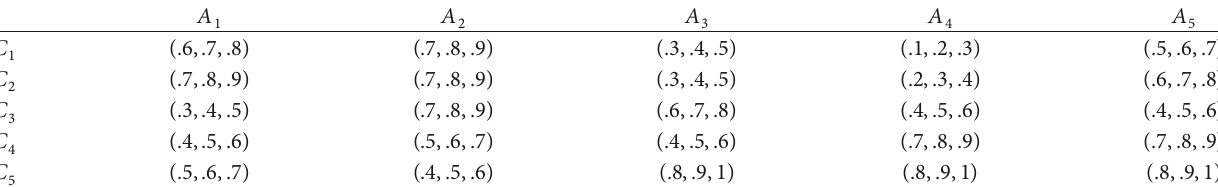
Table 1: Fuzzy decision matrix of expert 1.